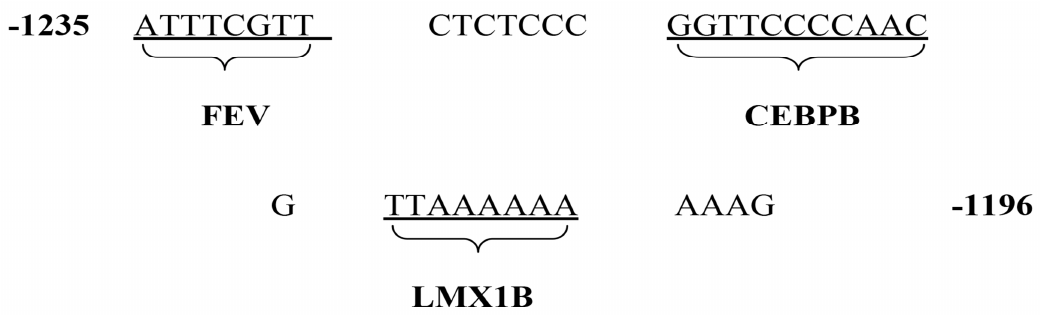
Figure 1. Prediction of transcription factor in the human HTR1A based on JASPAR software and related literature, the effect of the transcription factor CEBPB on the HTR1A expression were evaluated. FEV and LMX1B transcription factors may target fragments adjacent to the CEBPB binding sequence. Numbers represent sequence location (ATG+1), and bases recognized by the transcription factors are underlined.